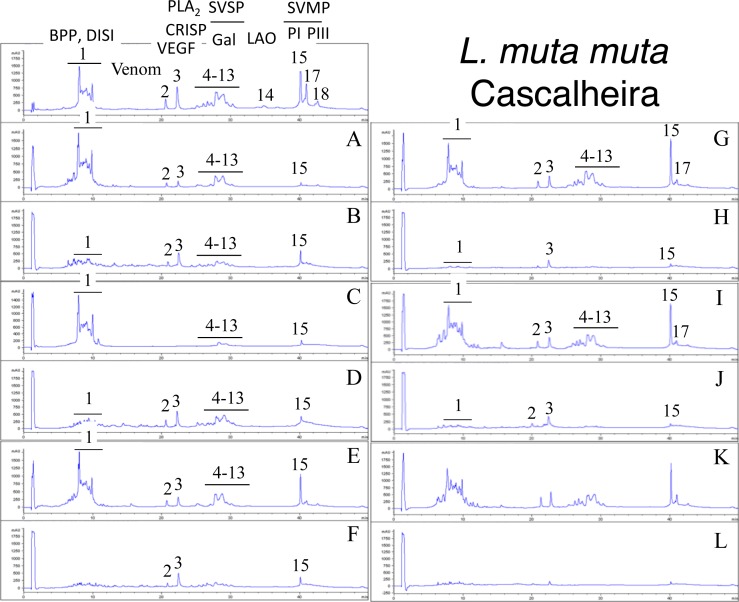
Immunoaffinity chromatography-based antivenomic analysis of the immunoreactivity of polyspecific and monospecific antivenoms towards the venom of L. muta muta from Cascalheira (Brazil).Panels display reverse-phase separations of whole venom components, and non-retained (A, C, E, G, and I) and the retained (B, D, F, H, and J) fractions recovered, respectively, from the affinity columns of immobilized BCL, BL, L, B, and C antivenoms. Panels K and L, non-retained and retained venom fractions by immobilized equine control immunoglobulins. CRISP, cysteine-rich secretory protein; other acronyms as in the legend of Fig 2.